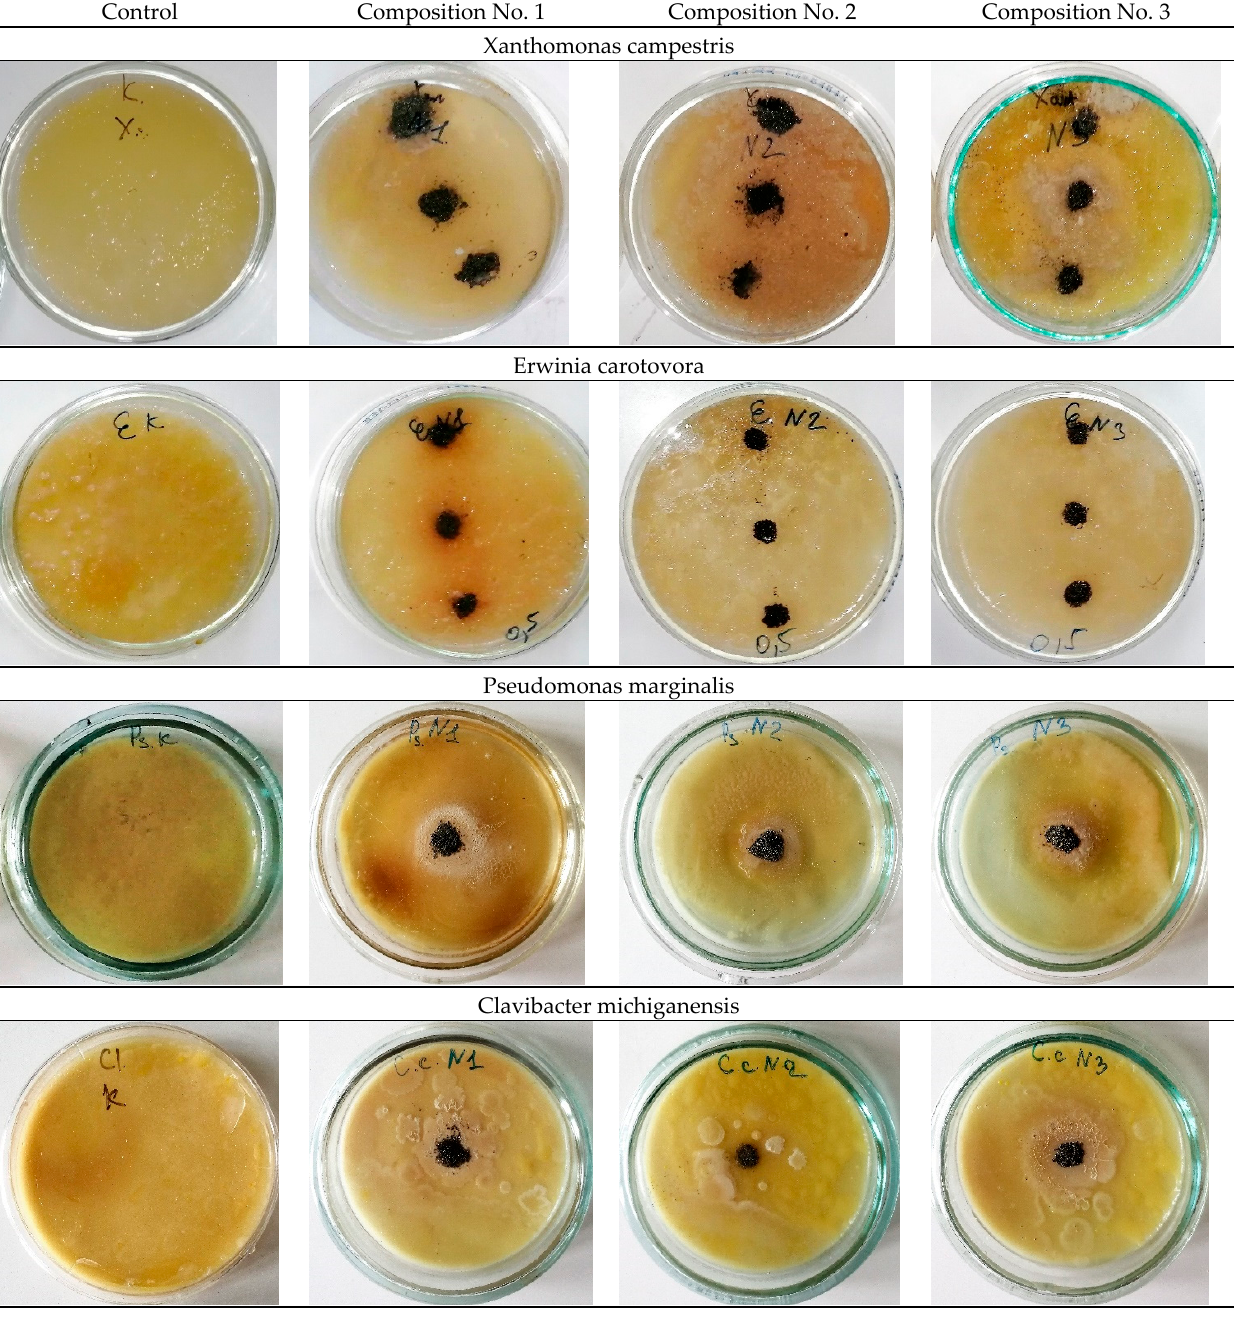
Figure 7. Powder samples in bacterial suspensions (No. 1—316L; No. 2—316L +0.2 wt.% Ag; No. 3—316L +0.5 wt.%